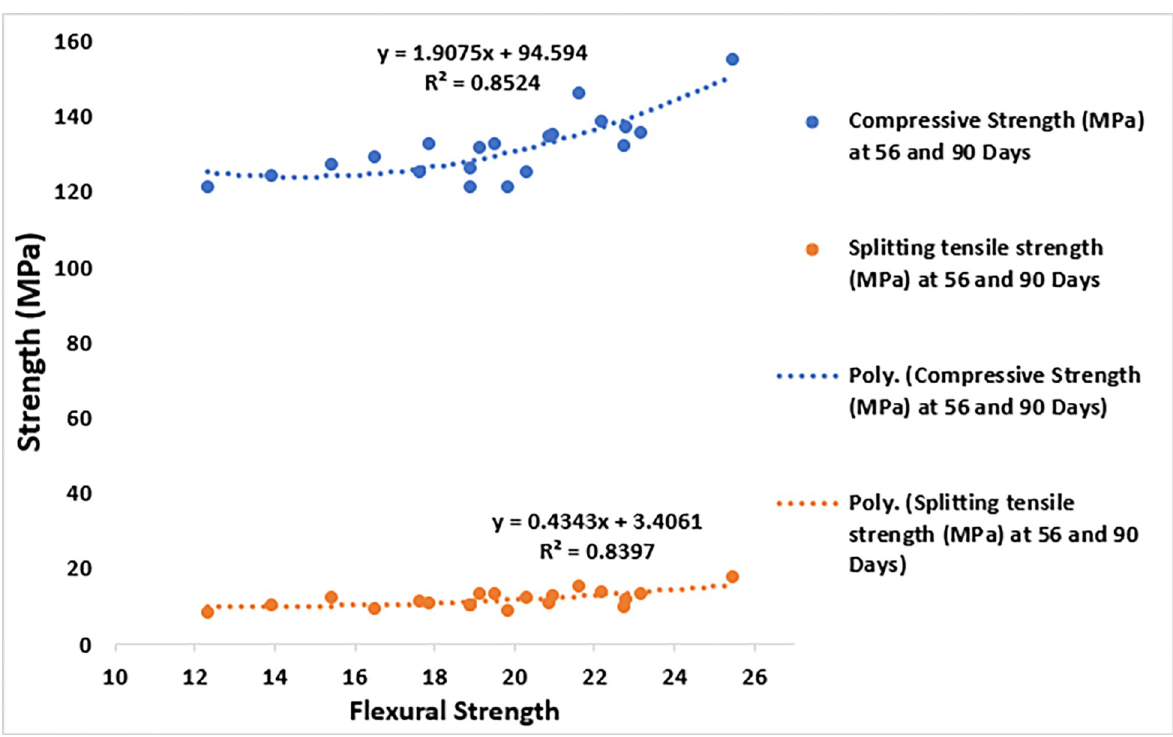
Fig 15. Polynomial regression analysis to predict flexural strength utilizing compressive and split tensile strength (MPa) at 56 and 90 days.